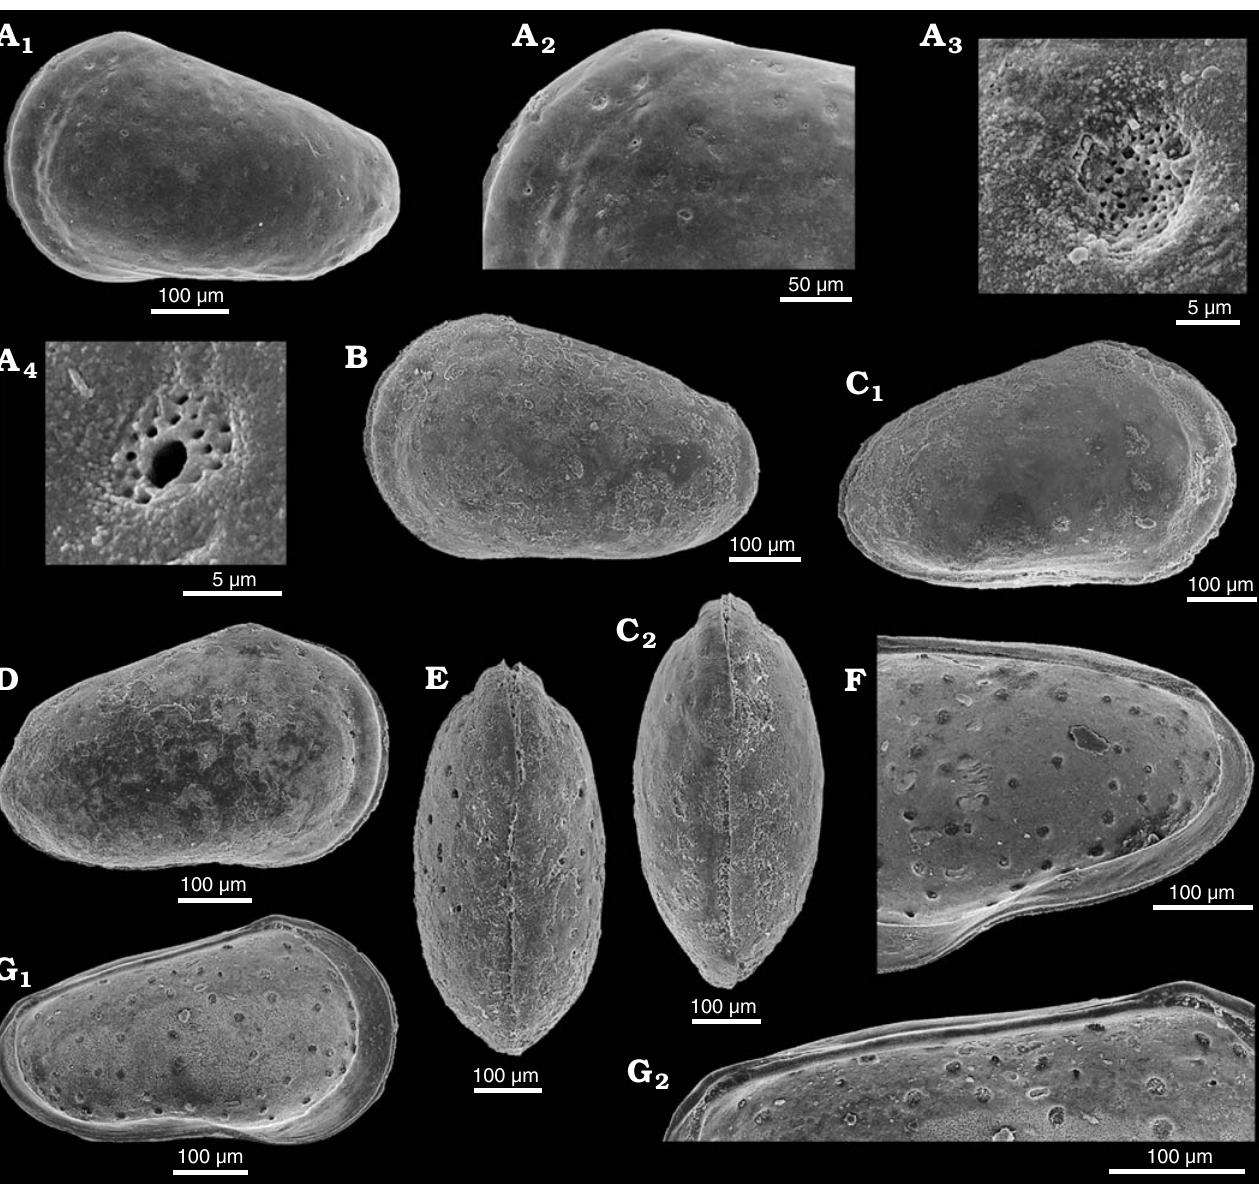
Fig. 10. Cytherid ostracod Minyocythere sp. cf. M . macroporosa sp. nov. from Borehole Rodewald WA12, 404.5 m (A), 386 m (B–E), 404.5 m (F, G), NW Germany, Witchellia laeviuscula Zone (Braun Jura γ upper), Lower Bajocian. A . SMF Xe 23725, male left valve in external view (A 1 ), antero-dorsal area (A 2 ), macro sieve-type normal pore canals (StPC-M) (A 3 ), and micro sieve-type normal pore canals (StPC-m) (A 4 ). B . SMF Xe 23726, female left valve in external view. C . SMF Xe 23727, female carapace in right (C 1 ) and dorsal (C 2 ) views. D . SMF Xe 23728, female right valve in external view. E . SMF Xe 23729, male carapace in dorsal view. F . SMF Xe 23730, fragment of female right valve in internal view. G . SMF Xe 23731, male left valve, internal view (G 1 ), hinge (G 2